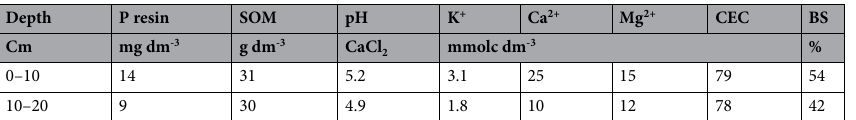
Table 4. Chemical attributes of the soil in the experimental area, before installing the experiment (November 2015). P resin phosphorus determined by the resin method, SOM soil organic matter, pH active acidity, K exchangeable potassium, Ca exchangeable calcium, Mg exchangeable magnesium, CEC cation exchange capacity, BS bases